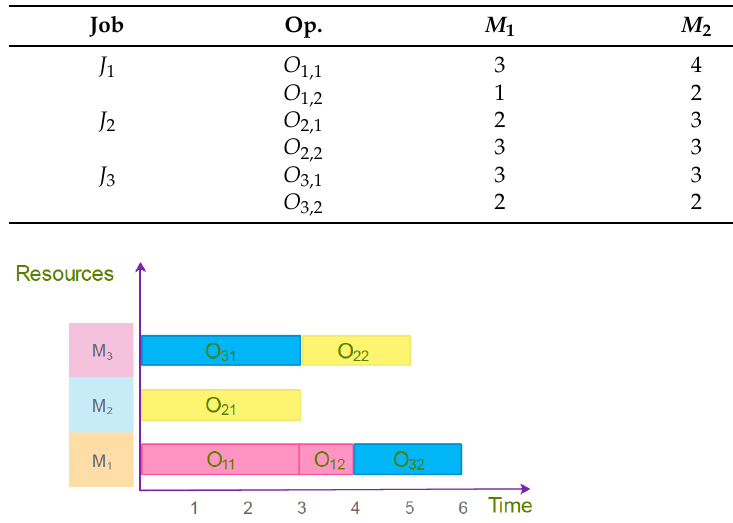
Table 1. Example of an FJSSP with 3 jobs, 3 operations per job, and 3 machines.